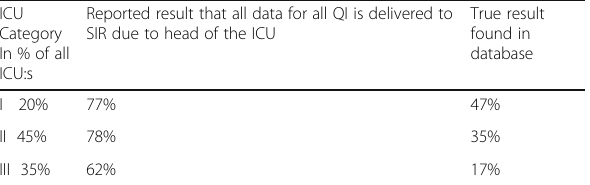
Table 1 (abstract 001661). The discrepancy of reported results according data concerning National Quality Indicators delivered to SIR compared the true result in the database